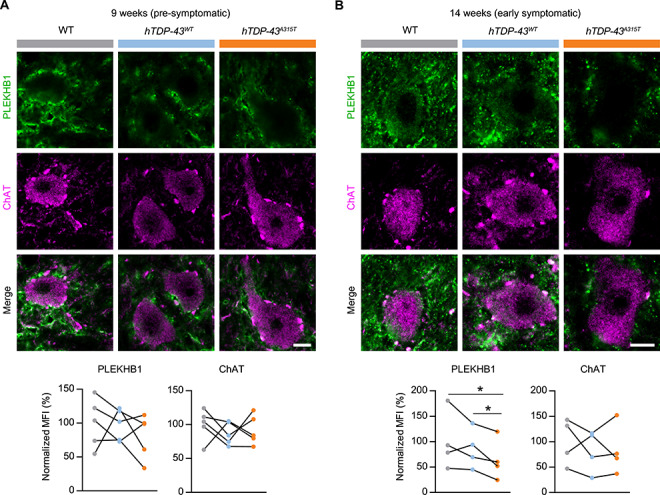
Decreased PLEKHB1 protein levels in spinal cord MNs of hTDP-43A315T ALS mice after disease onset. Immunofluorescent confocal images of PLEKHB1 and ChAT co-staining of spinal cord MNs from L3–5 of hTDP-43A315T (A315T), WT and the asymptomatic hTDP-43WT control (hTDP-43). Representative images are shown for 9-week-old (A) and 14-week-old (B) mice with quantification of mean fluorescent intensity (MFI). n = 4–5; values for each genotype from each specific experiment are shown; corresponding genotype pairs from a specific replicate are linked by black lines; paired t-test; *P < 0.05; scale bar: 10 μm.